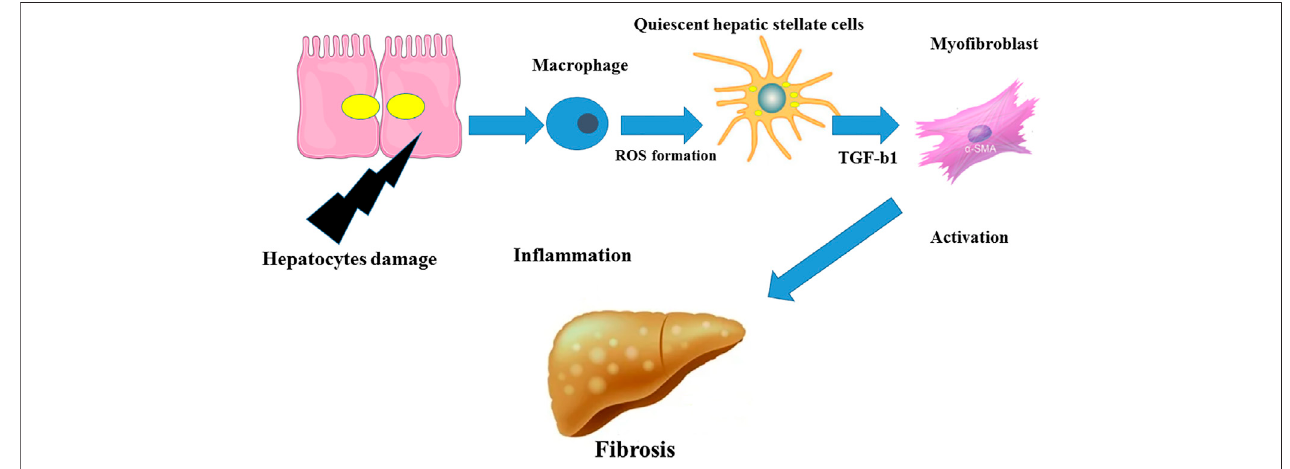
FIGURE 1 | In fl ammation in fi brosis. The in fl ammatory response could be induced by hepatocyte damage leading to the activation of macrophages and to a production of ROS and TGF- β 1 and to the differentiation of quiescent HSCs in MFBs which in turn may trigger liver fi